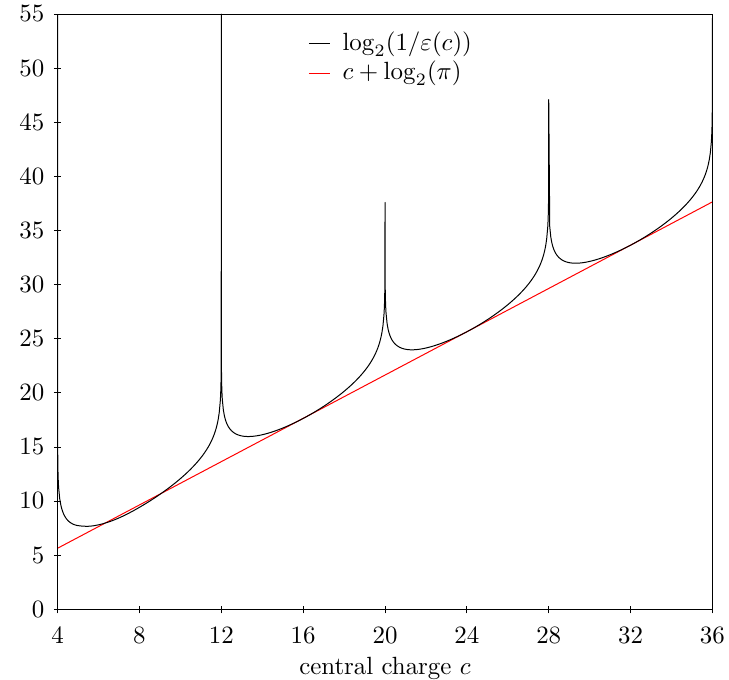
( c ) − ( n + ( c − 4) / 8) | over 2 c ≤ n ≤ 128 n